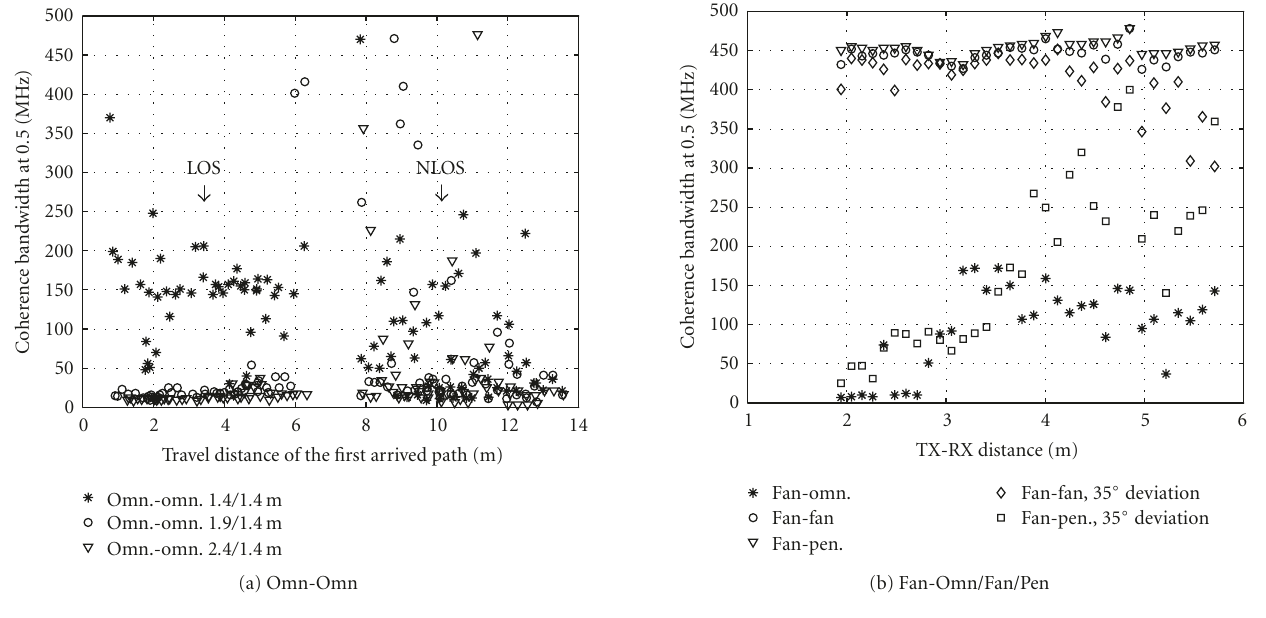
Figure 5: The coherence bandwidth at level 0.5 over the travel distance of the first arrived path.